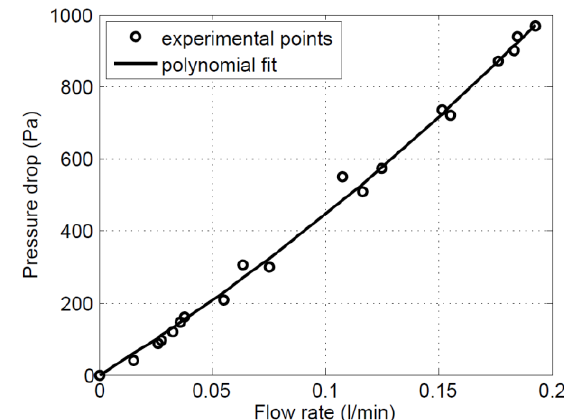
Fig. 2. A pressure drop of the heat exchanger shown in the foreground of Figure